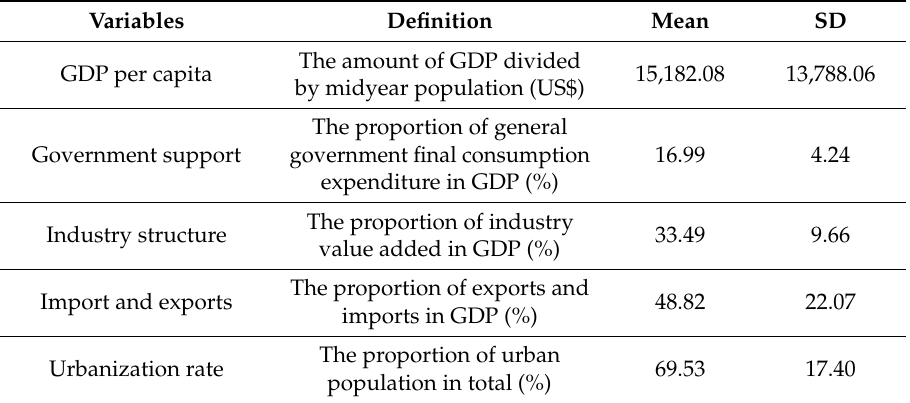
Table 2. Descriptive statistics of external environmental